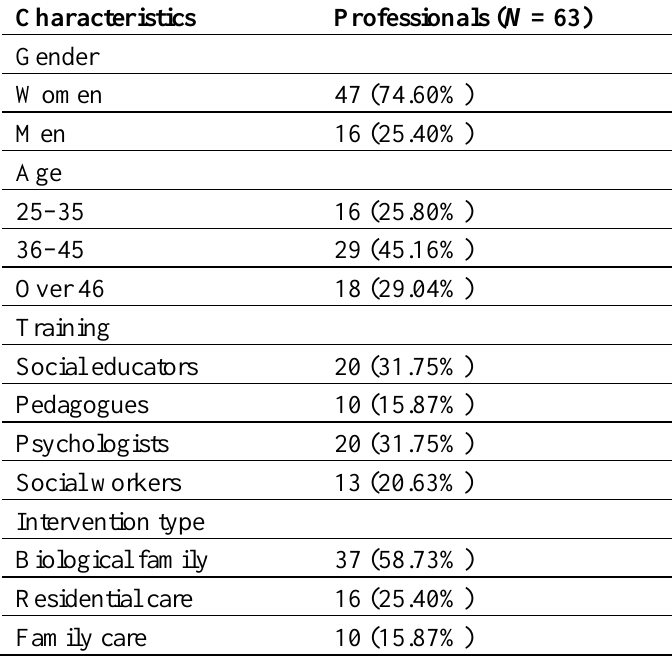
Table 1. Characteristics of the participating professionals.